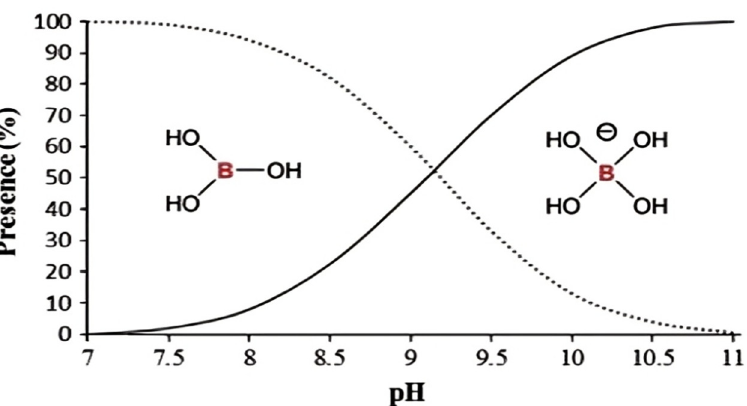
Figure 4. Existence of boron at different pH values. Reprinted with permission from Ref. [32], 2014, Elselvier.